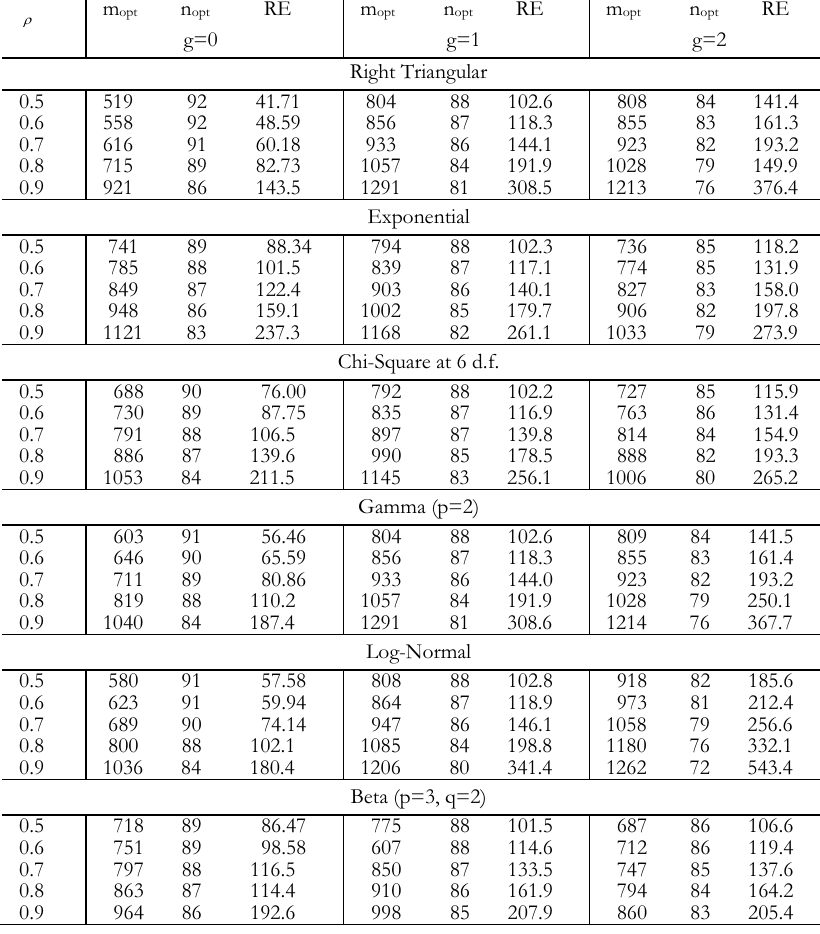
Plan of results for estimator of population mean in double sampling using